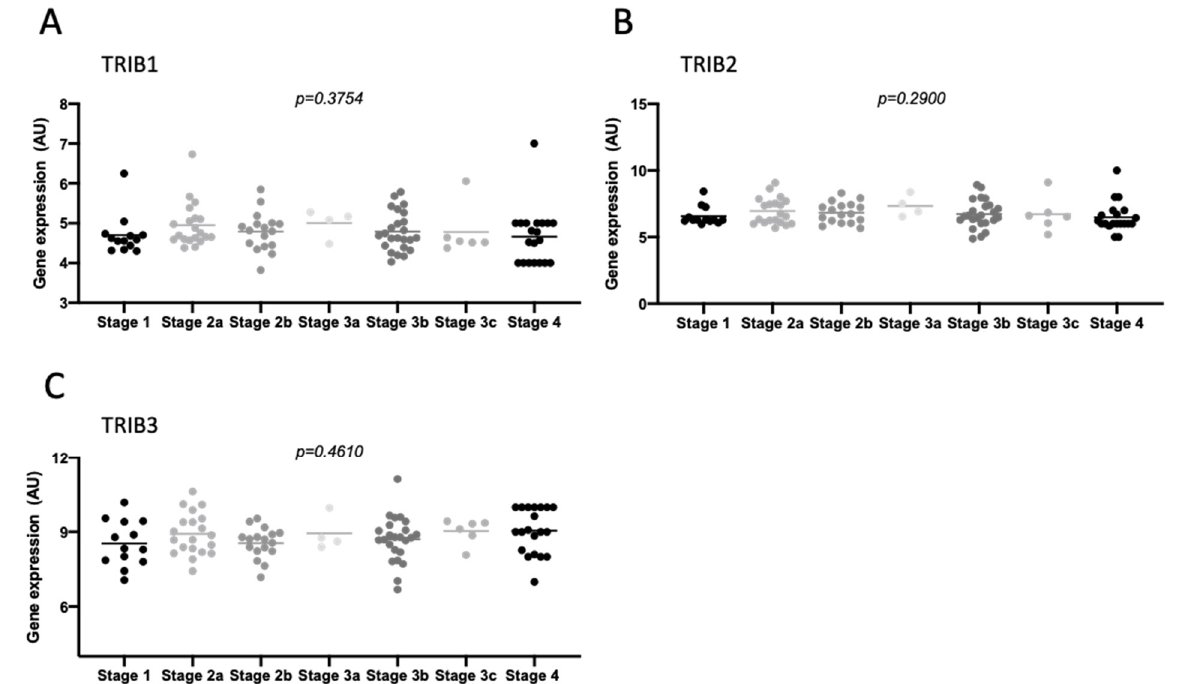
Figure 5. TRIB1 , TRIB2 , and TRIB3 gene expression in CRC tumors with different staging. ( A – C ): CRC tumors representing various stages ( n = 4–24 each group) (GDS4516), including patients with no metastasis, patients with metastatic recurrence after surgery, and patients with distant metastases. Samples are plotted individually. TRIB1 (( A )—202241_at), TRIB2 (( B )—202478_at), and TRIB3 (( C )—218145_at) gene expression is represented as arbitrary units (AU). Kruskal–Wallis test was performed, and the p value is represented for each graph. The horizontal bars represent the mean of the values in each group.